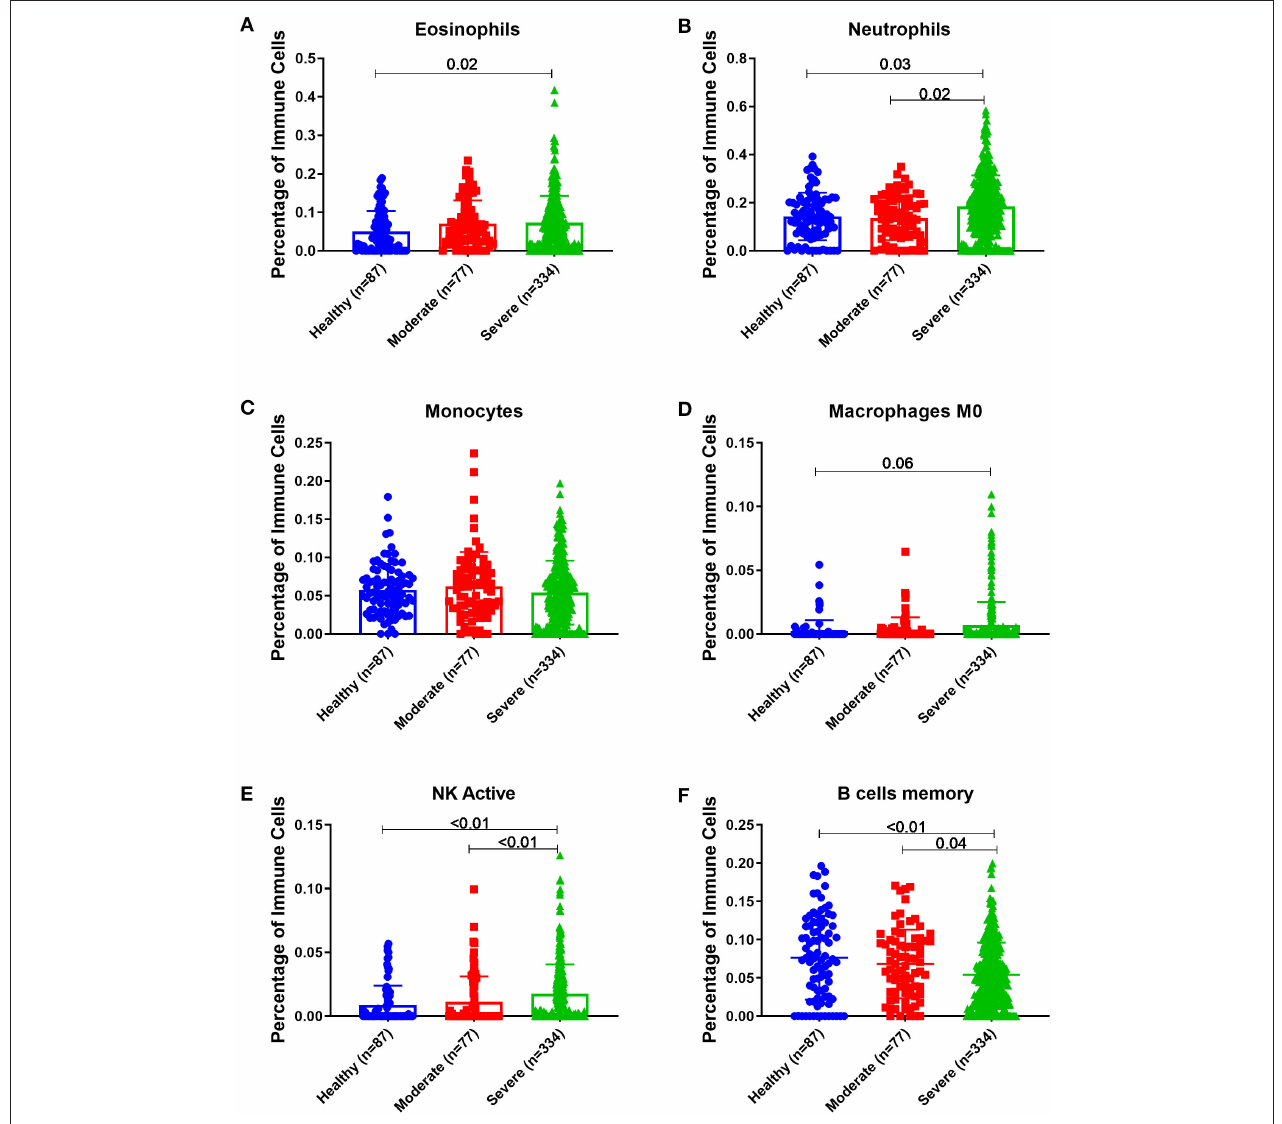
FIGURE 9 | Estimating immune cells populations in blood of (GSE69683) dataset to compare healthy controls ( n = 87), non-severe asthma ( n = 77), and severe asthmatics ( n = 334). Blood genes expression was loaded to CIBERSORT in silico flow cytometry and immune cells which showed significant differences between the groups are shown. (A) Eosinophils, (B) Neutrophils, (C) Monocytes, (D) Macrophages M0, (E) NK active, and (F) B cells memory.